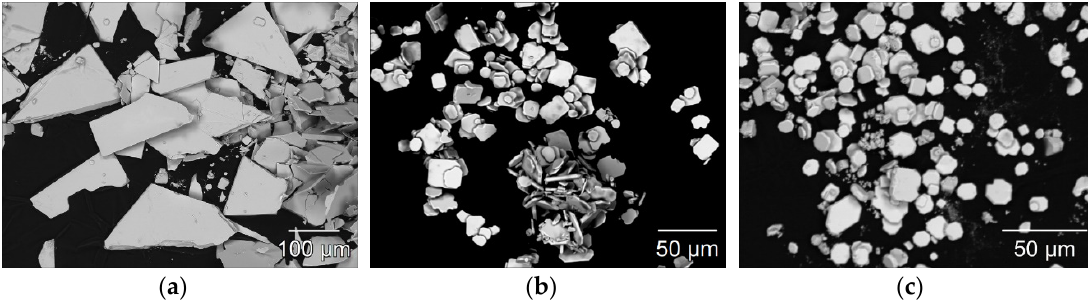
Figure 8. Scanning electron images of EuSb 2 O 4 Br ( a ), GdSb 2 O 4 Br ( b ), and TbSb 2 O 4 Br ( c ) illustrating the platelet crystal habit with typical edge lengths of 50 ‒ 150 µm for the europium compound and 10 ‒ 35 µm for the gadolinium and terbium representatives.